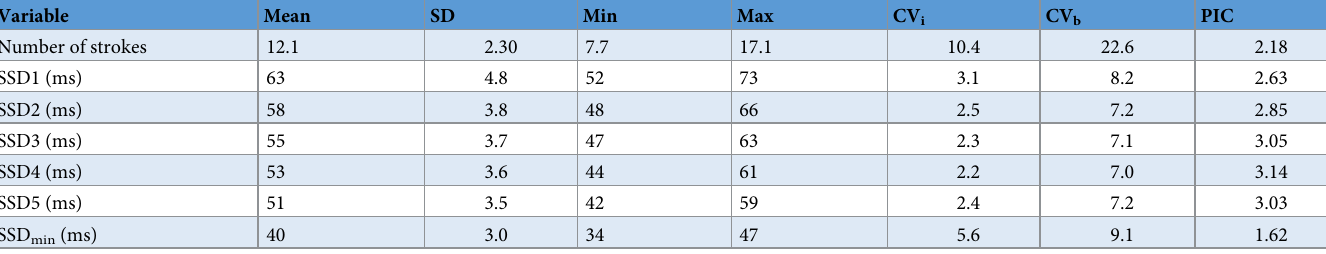
Table contains mean values of analysed drumming parameters: Number of strokes; SSD1-5 –first five stroke-to-stroke durations, SSDmin—minimum SSD. Mean values (Mean), standard deviation (SD), minimal (Min) and maximal (Max) values, within- (CV i ) and between-individual coefficient of variation (CV b ), and potential for identity coding (PIC) are given. Table based on 609 rolls belonging to 41